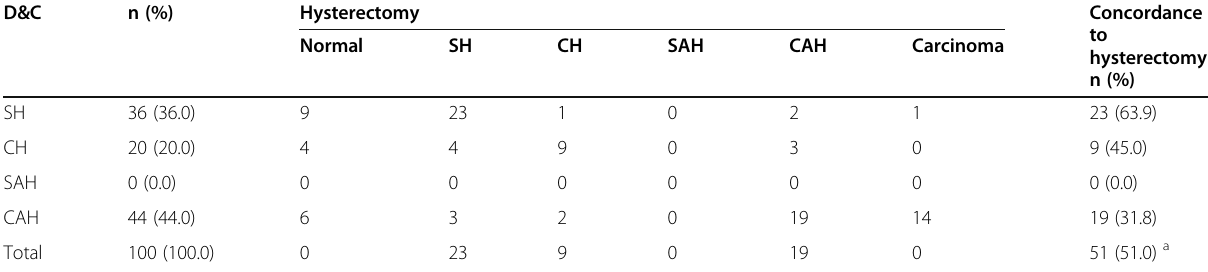
Table 2 Comparison of pathological results of D&C and